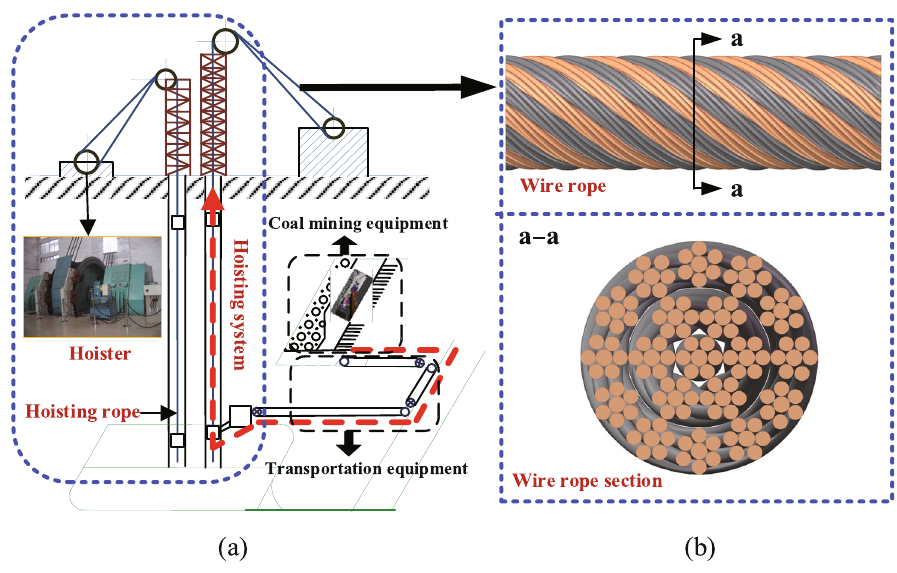
Fig. 1 Mine hoisting diagram. (a) Mine hoisting system and (b) hoisting